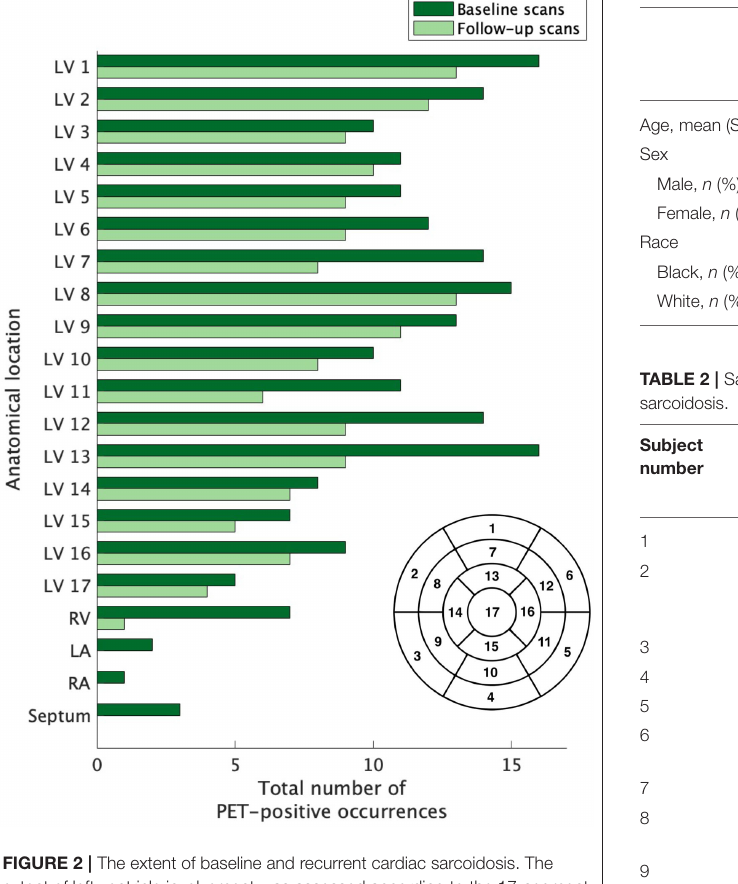
TABLE 1 | Clinical features of patients with recurrently active sarcoidosis.